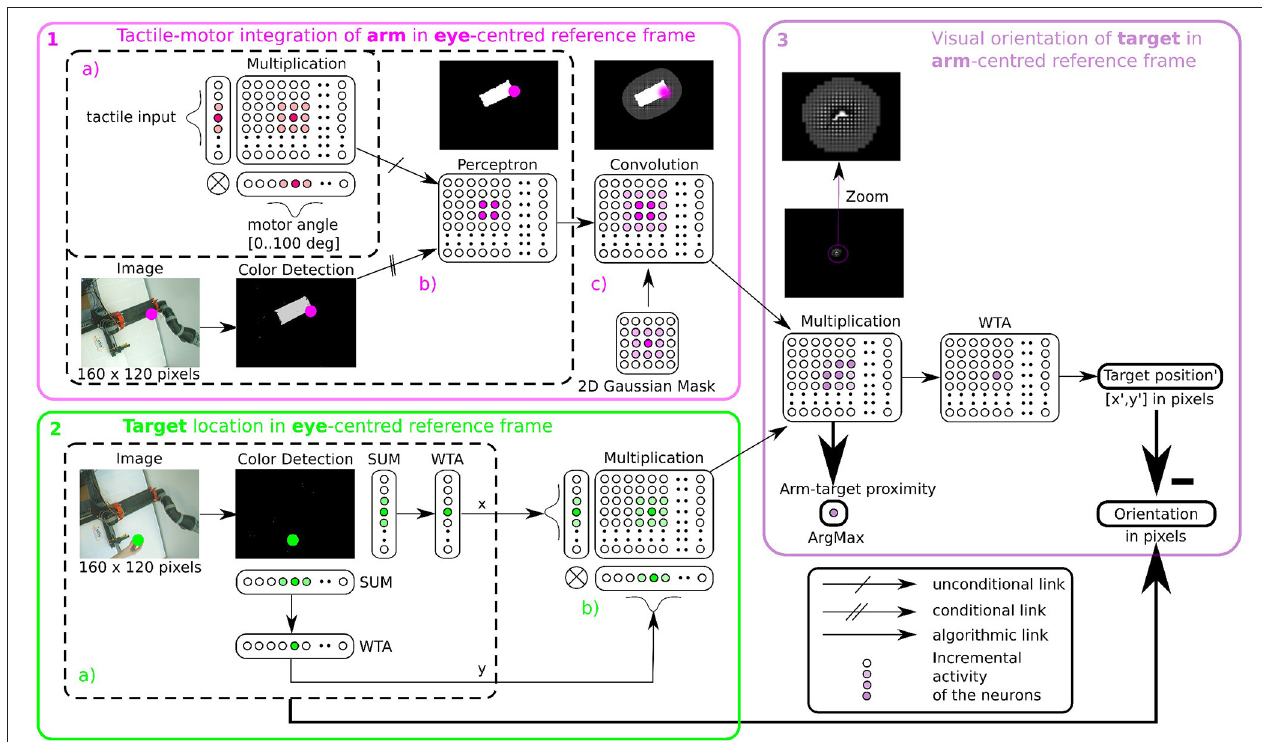
FIGURE 5 | Algorithmic implementation of tactile, visual, and motor integration. The principle of integration is based on the three successive step marked in pink (1) , green (2) , and purple (3) . Descriptions of each part are presented in section 2.2.4.1 respectively. Part 1 and 2 correspond to tactile-motor integration based on GF computation for eye-centered RF of the arm (HE) and of the target (TE); they contain subparts (a–c) outlined in dotted lines. Part 3 corresponds to the computation of the target in arm-centered RF